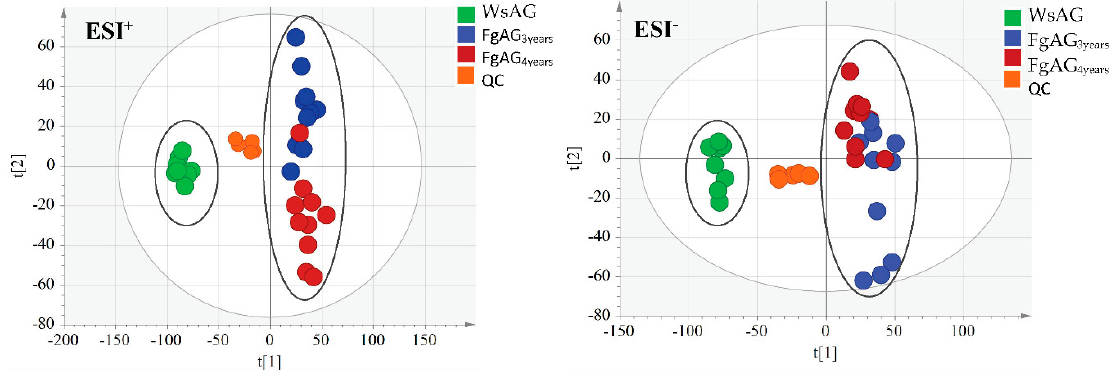
Figure 3. The PCA of FgAG and WsAG in positive mode and negative mode.